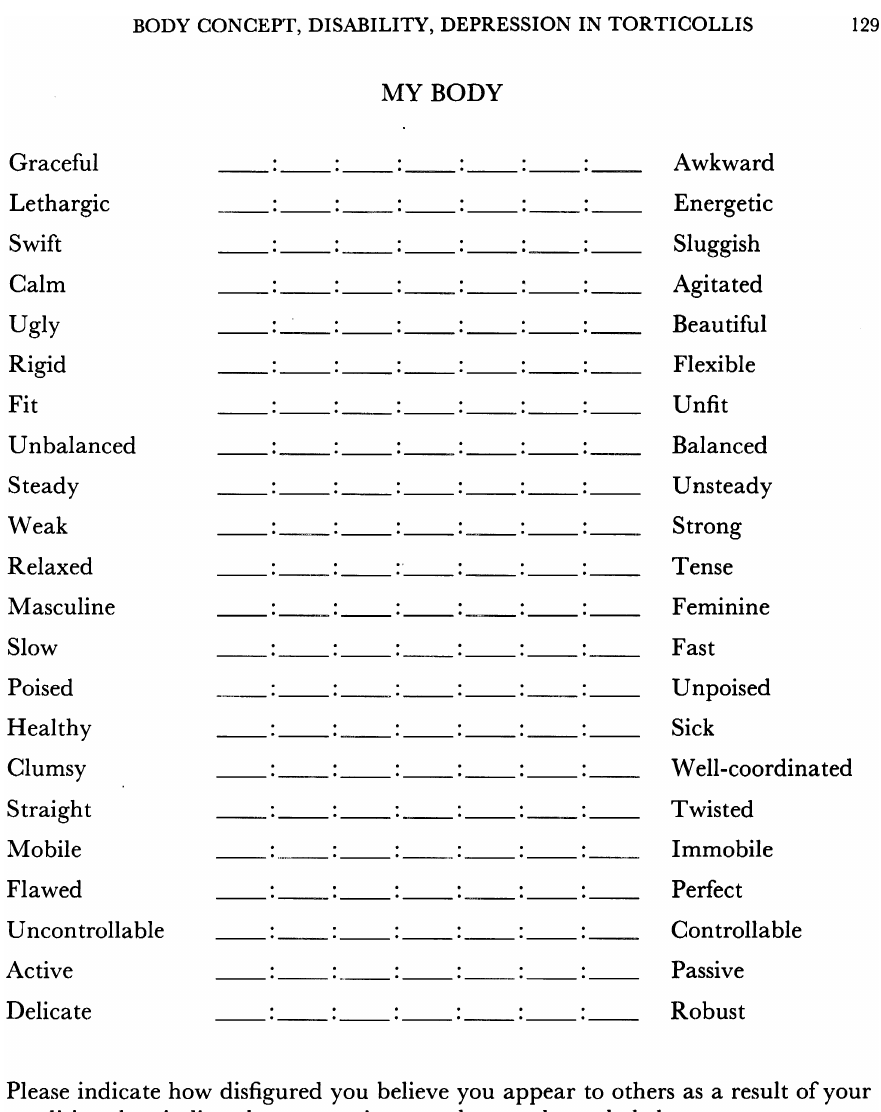
Active Delicate Please indicate how disfigured you believe you appear to others as a result of your condition, by circling the appropriate number on the scale below,